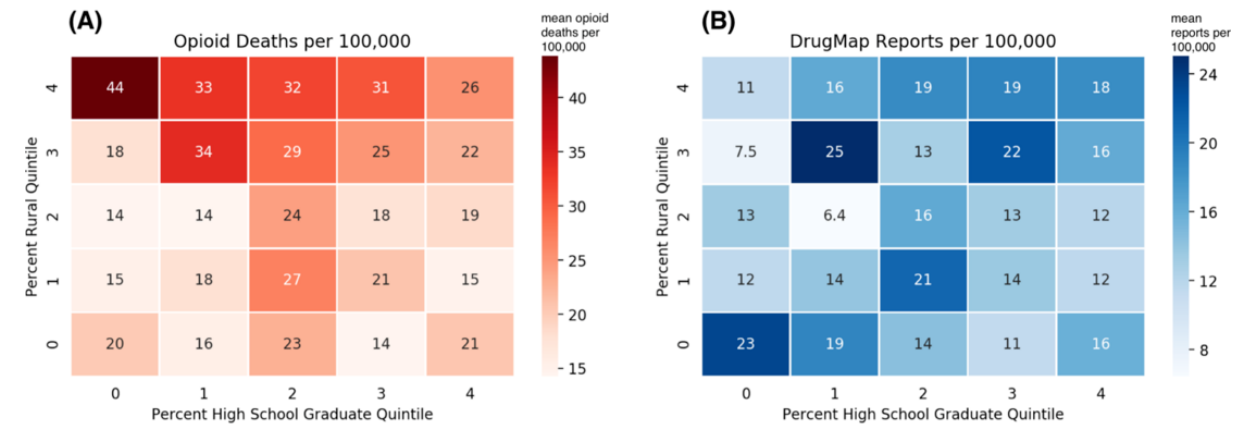
Figure 2. Heatmap showing distribution of opioid-related death rate (A) 2017 and DrugMap report rate (B) 2018-2019 by percent rural and percent high-school